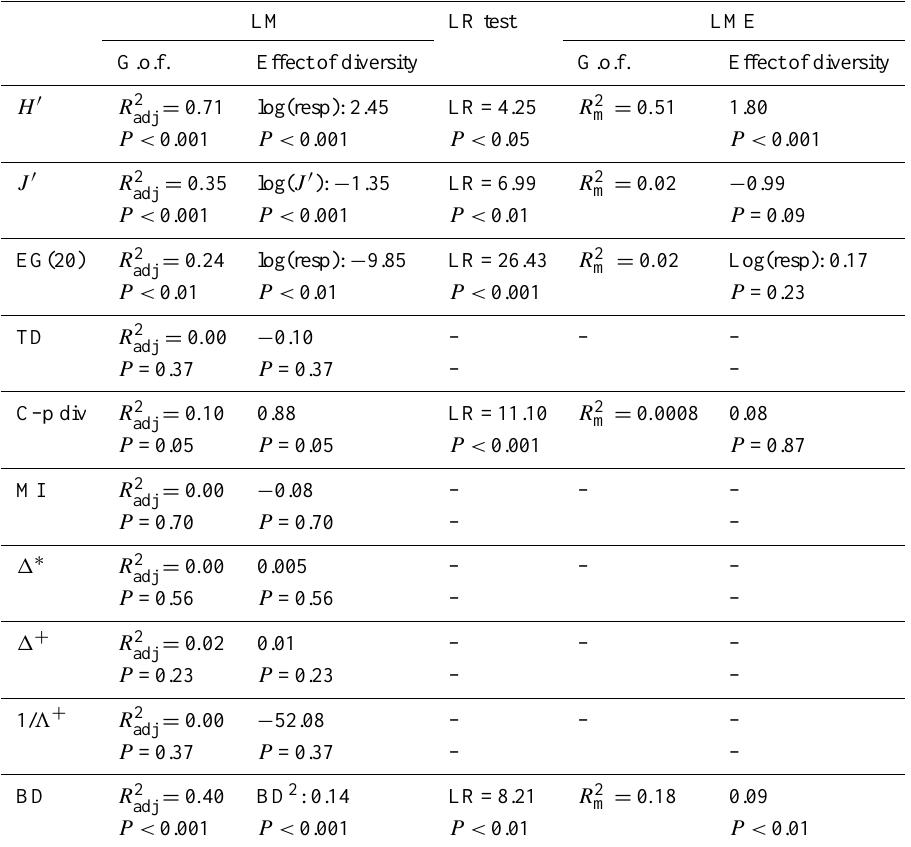
Table 4. Results of linear models (LM), the likelihood ratio (LR) test and linear mixed-effect models (LME) for the regression of nematode diversity against total respiration. The estimated average size of the effect and the associated P value are given per diversity index. For H 0 and EG(20), respiration (resp) was log e transformed to comply with the assumptions of linear regression. J 0 and BD were log e transformed and squared, respectively, to comply with assumptions. H 0 : Shannon–Wiener diversity, EG(20): expected genus richness for a sample of 20 individuals, J ’: Pielou’s evenness, TD: trophic diversity, c–p diversity: diversity of c–p (life history) classes, MI: maturity index, 1 + : average taxonomic distinctness based on presence–absence data, 1 ∗ : average taxonomic distinctness based on quantitative data, 1/ 3 + : taxonomic evenness, BD: biomass diversity, R 2 : adjusted R 2 , R 2 m : marginal R 2 , and G.o.f.: goodness of adj